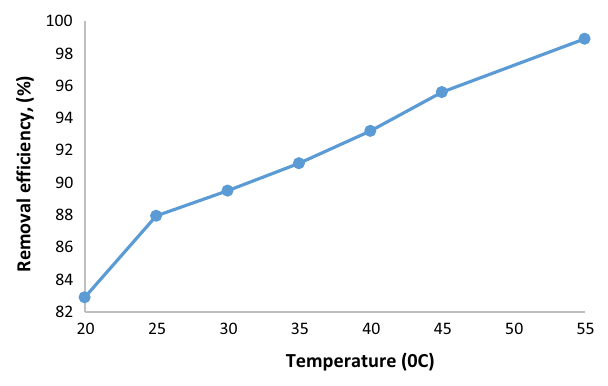
Fig. 8 Effect of temperature on the removal of As(III)